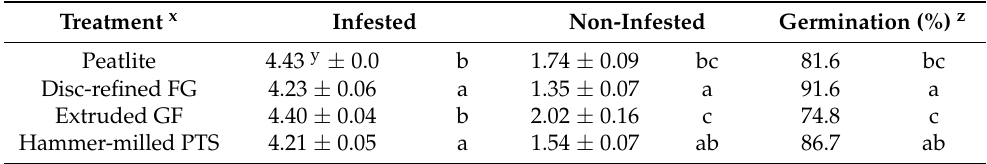
Table 4. Mean damping-off disease severity rates ± standard error in R. solani -infested and non- infested pots and natural germination rates in non-infested pots seven days post-seeding in the four substrate treatments. Treatment x Infested Non-Infested Germination (%) z Peatlite 4.43 y ± 0.0 b 1.74 ± 0.09 81.6 bc Disc-refined FG 4.23 ± 0.06 a 1.35 ± 0.07 91.6 Extruded GF 4.40 ± 0.04 2.02 ± 0.16 74.8 c Hammer-milled PTS 4.21 ± 0.05 a 1.54 ± 0.07 ab 86.7 ab